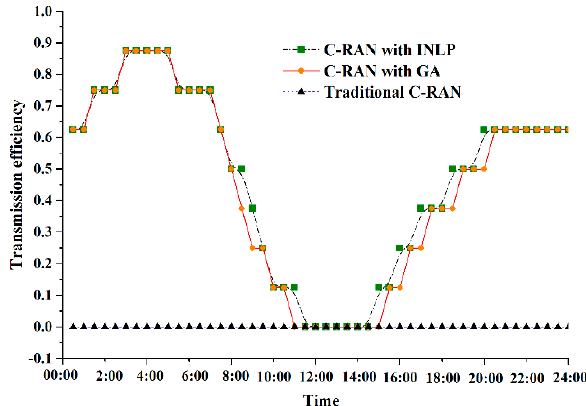
Figure 5. Transmission efficiency of fronthaul with different methods.